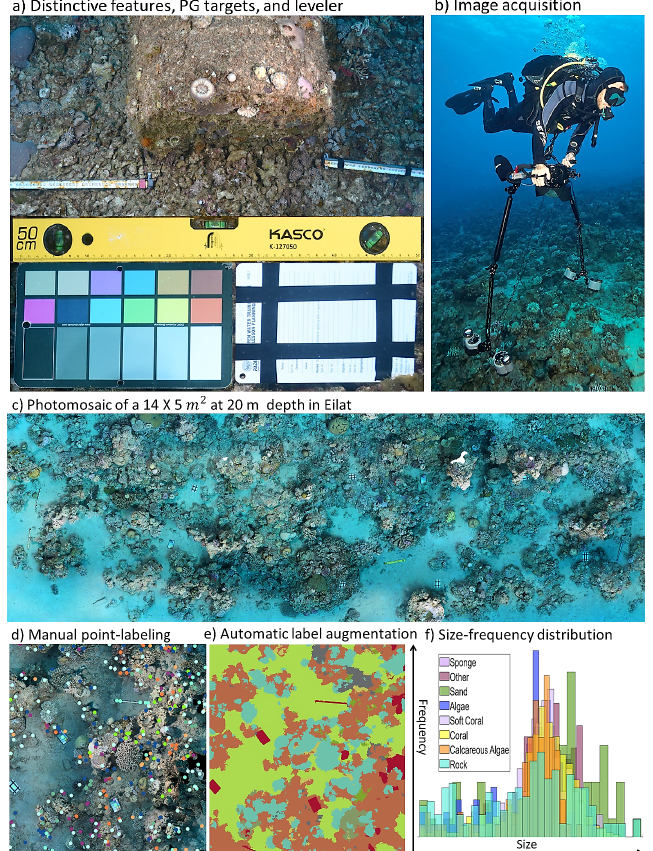
Figure 3. Workflow for semantic mapping: ( a ) Scale bars are located next to a distinguishable object at the survey starting point, slate and colour-card are used as photogrammetric targets, and the spirit leveler is aligned in the scene and used for 3D grid definition in post processing. ( b ) Image acquisition is carried out using a diver-held imaging system. ( c ) An RGB photomosaic is produced and ( d ) labeled sparsely. ( e ) Labels are augmented for full terrain depiction using Multi Level Superpixels (MLS). ( f ) Community statistics such as class specific size-frequency distribution are extracted